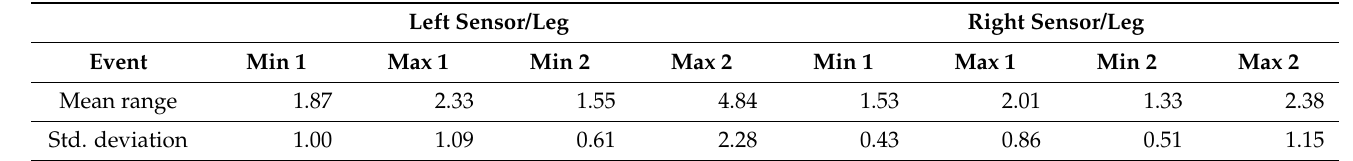
Table A1. Range of variation in degree ( ◦ ) within every 5 min (recorded once every minute) of a measurement cycle.